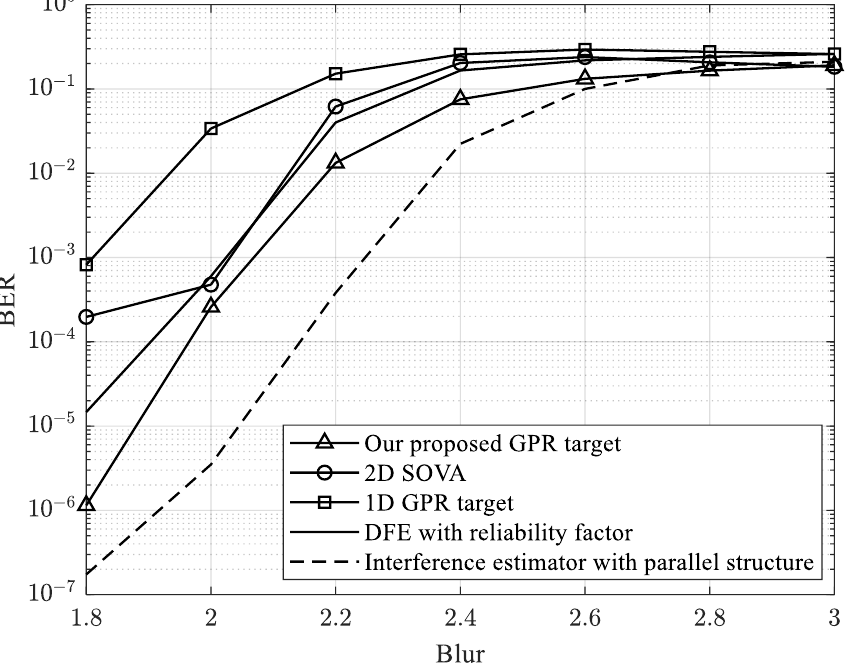
Figure 7. BER of the proposed GPR target varying the blur from 1.8 to 3 at 0% misalignment.